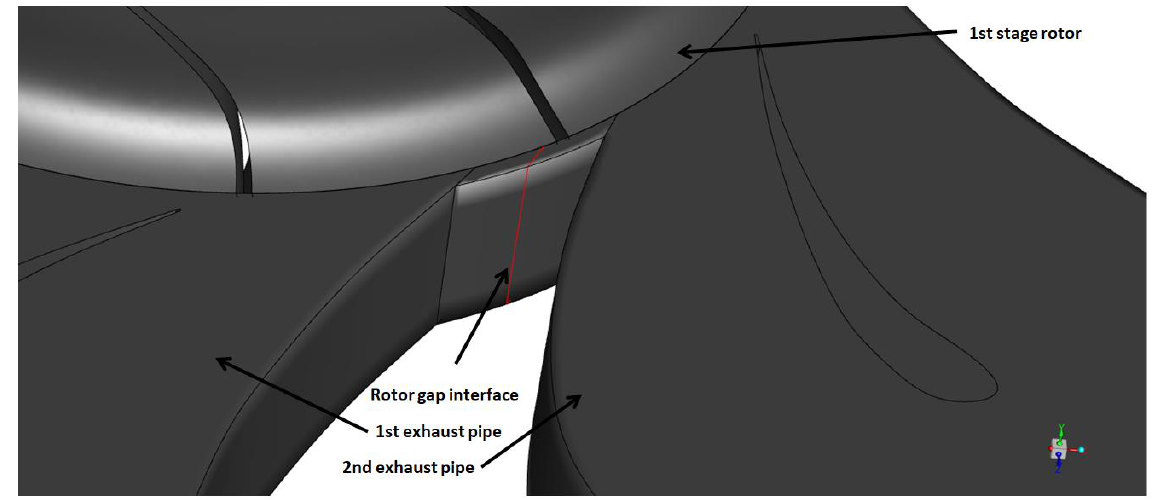
Figure 18. The position of the mass-flow rate monitor at the rotor gap domain.